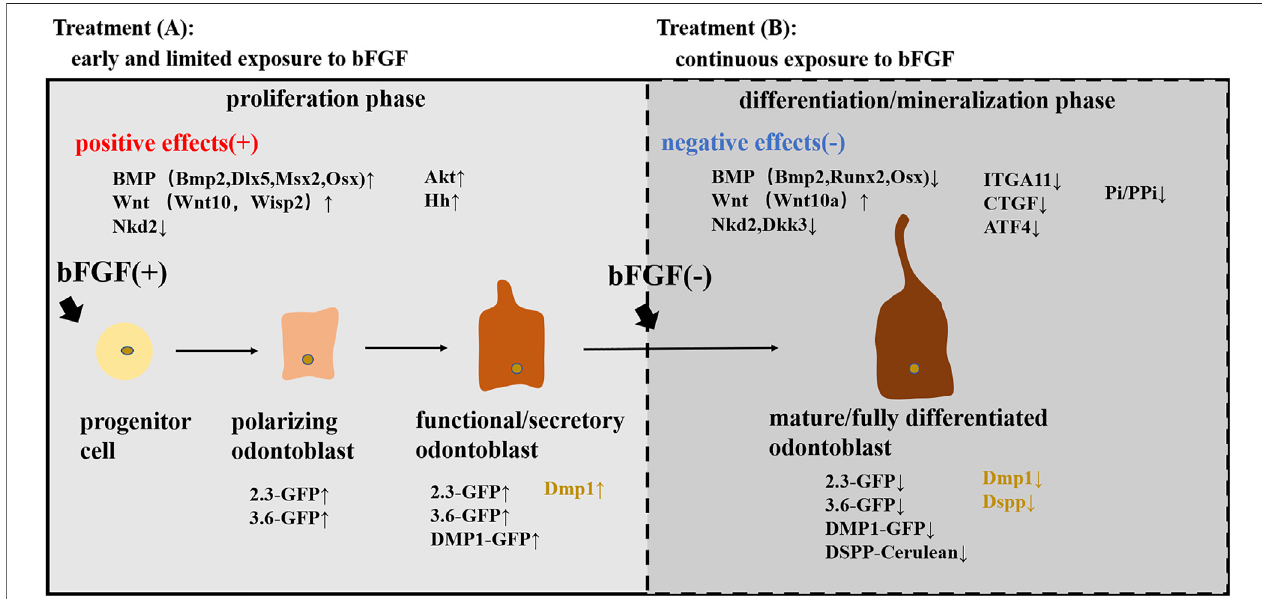
FIGURE 2 | Stage-speci fi c effects of the bFGF on odontoblast differentiation. Treatment (A) : early and limited exposure to the bFGF during the proliferation phase stimulated the differentiation into functional/secretory odontoblasts and increased the expression of various GFP transgenes (2.3-GFP, 3.6-GFP, and DMP1-GFP) and dentinogenic markers (Dmp1) by activating the BMP, Wnt, and Akt pathways. Treatment (B) : continuous exposure to the bFGF during the differentiation/mineralization phase inhibited the differentiation into mature odontoblasts and decreased the expression of GFP transgenes (2.3-GFP, 3.6-GFP, and DSPP-Cerulean) and dentinogenic markers (Dmp1 and Dspp) by activating the Wnt pathway while suppressing the BMP pathway and downregulating ITGA11, CTGF, and ATF4 levels and the Pi/PPi ratio.